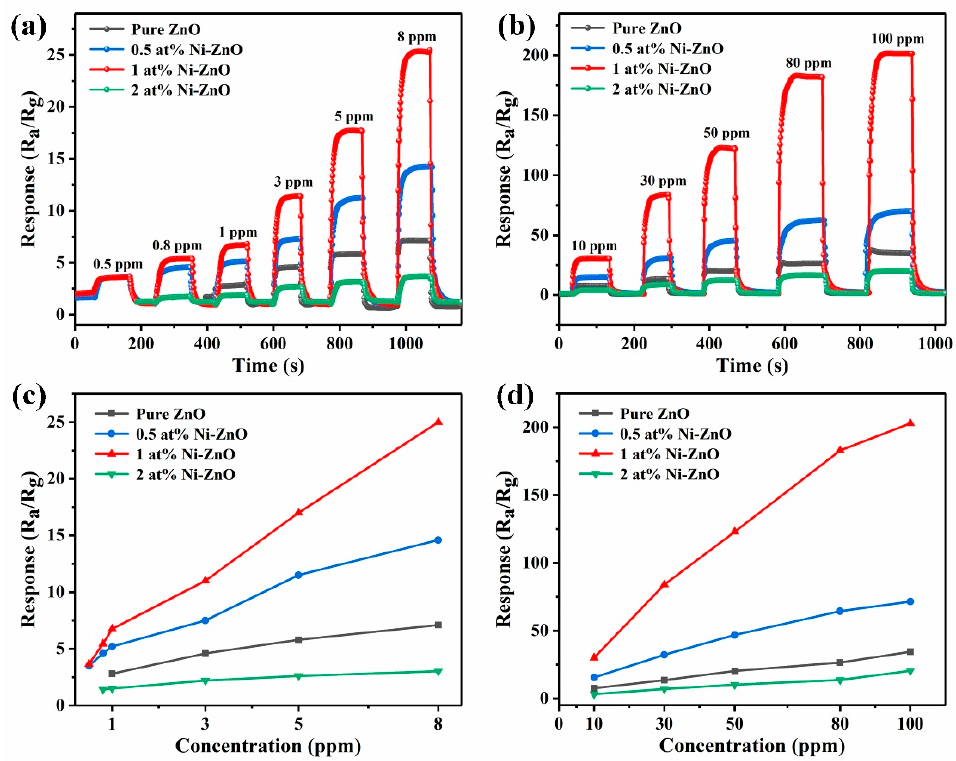
Figure 8. ( a , b ) The dynamic response curves of the four sensors to toluene with different concentra- tions at 375 °C (pure ZnO) and 325 °C (Ni–ZnO samples). ( c , d ) The response of the pure, 0.5, 1, and 2 at% Ni–ZnO sensors to (0.5–100 ppm) toluene.